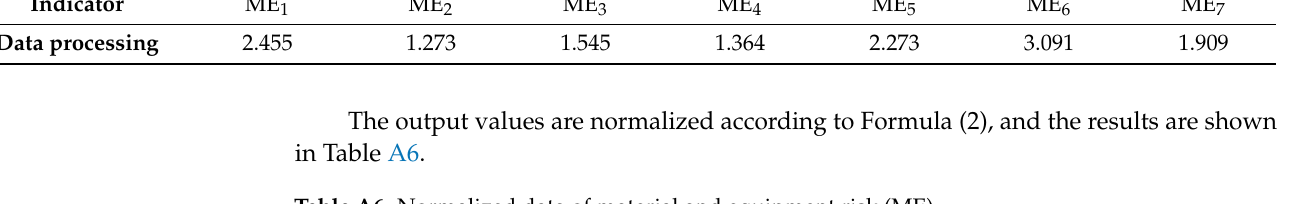
Table A6. Normalized data of material and equipment risk (ME).